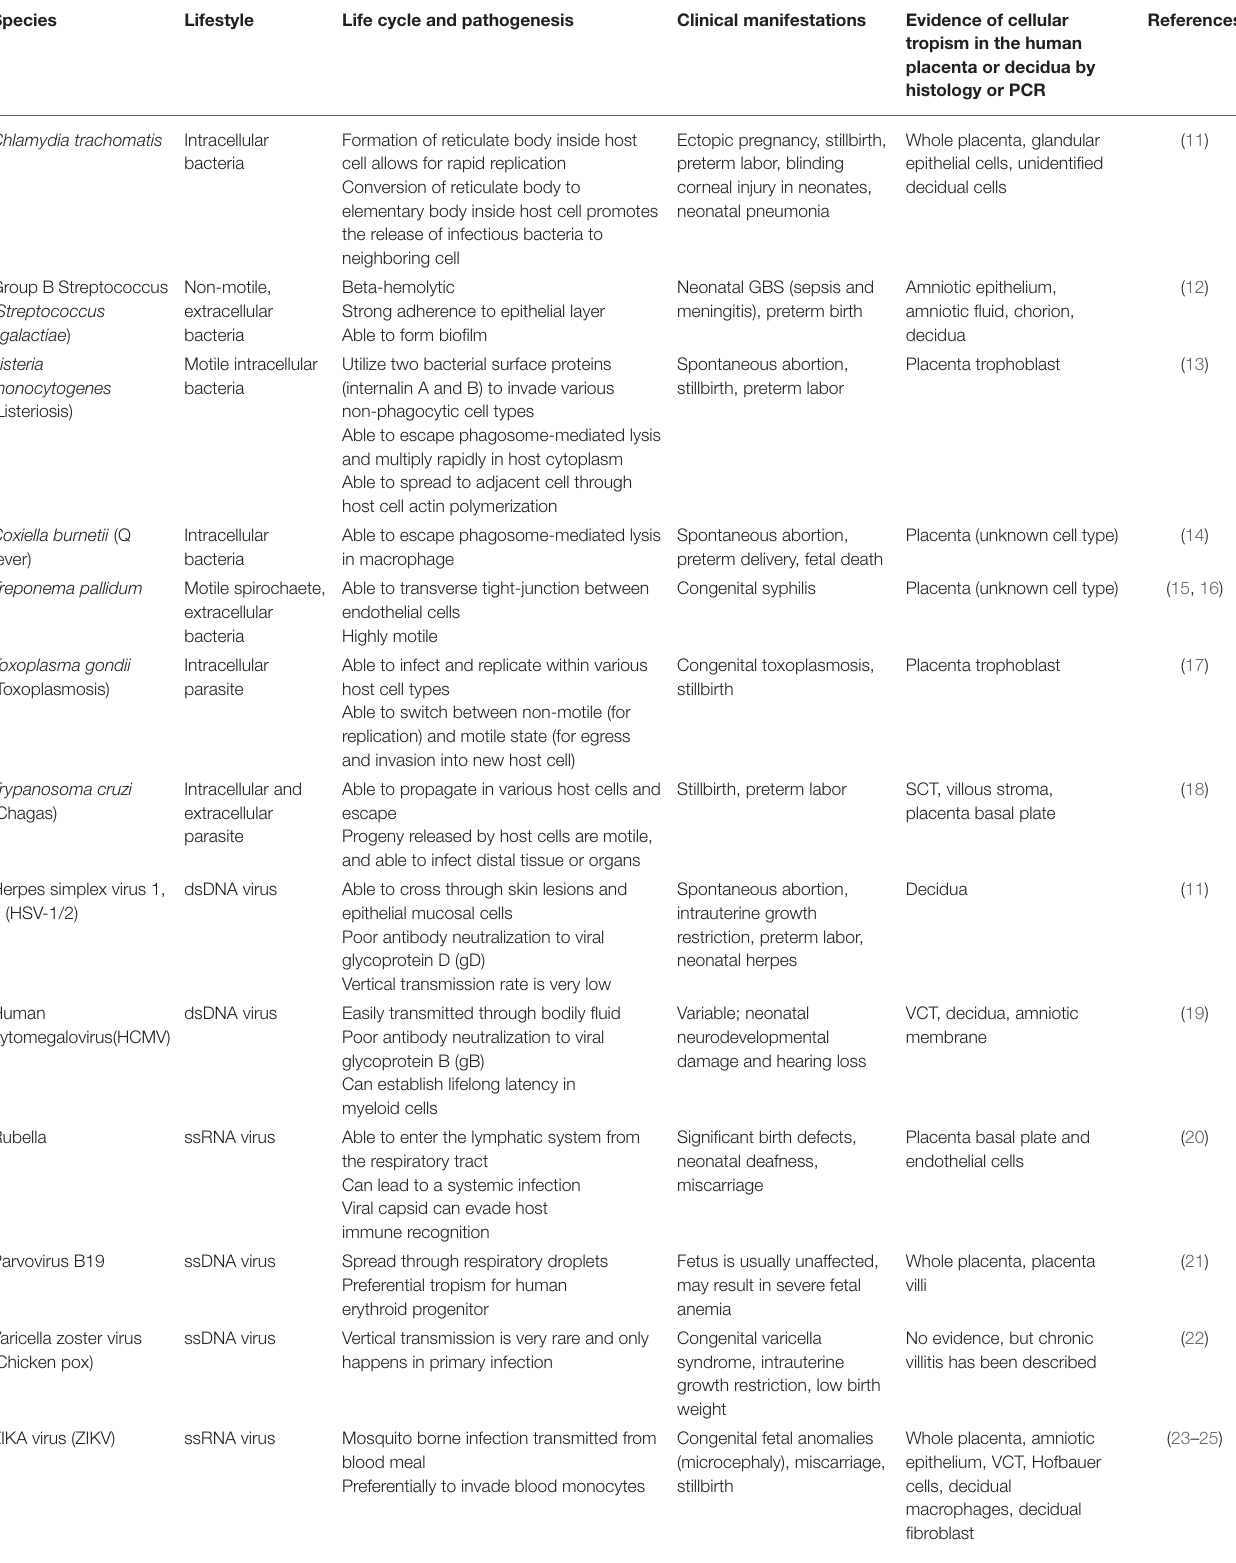
TABLE 1 | Vertically transmitted pathogens with clinical evidence from natural human infection.